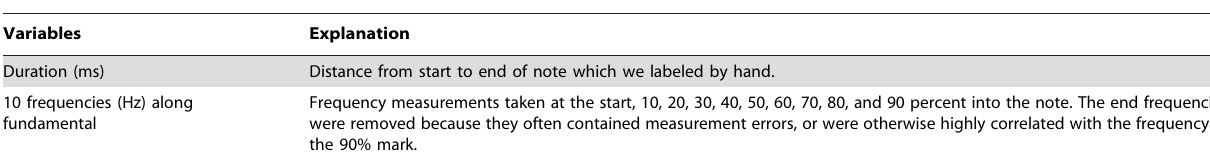
Table 2. Acoustic variables used for discriminant function